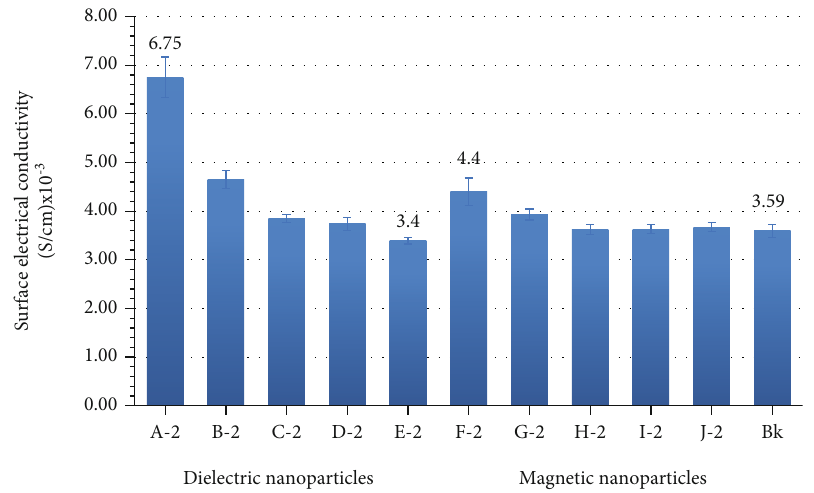
Figure 7: E ff ect of magnetic and dielectric nano fi llers on the surface electrical conductivity of developed composite samples (A: MWCNTs, B: SiC, C: Gp, D: CB, E: MnO